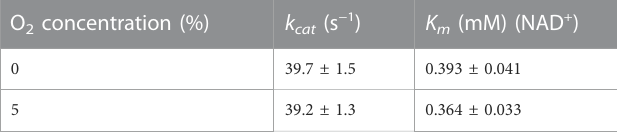
TABLE 1 Kinetic parameters of ReSH under presence of O 2 or not.